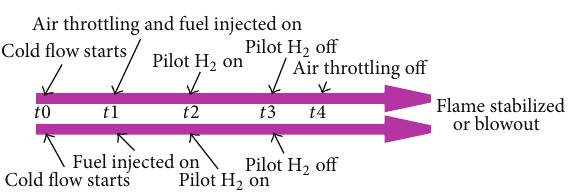
Figure 2: Schematic illustration of the scramjet.